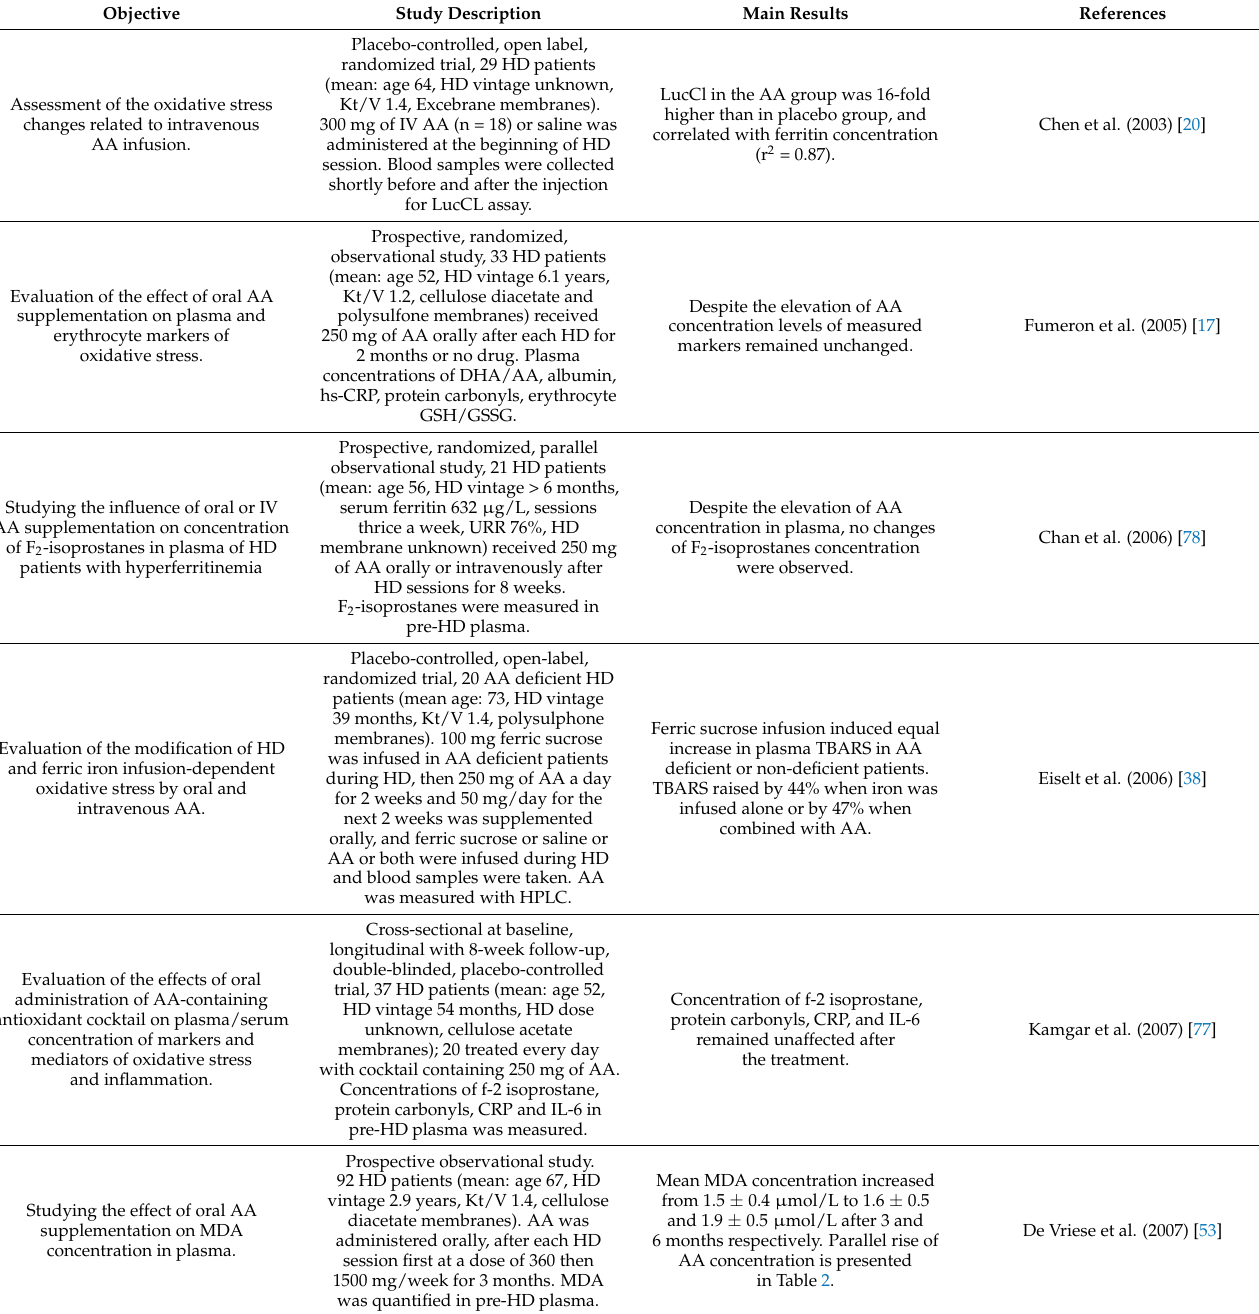
Table 5. Studies demonstrating no effect or unfavorable effects of vitamin C supplementation on oxidative stress or inflammation in hemodialysis